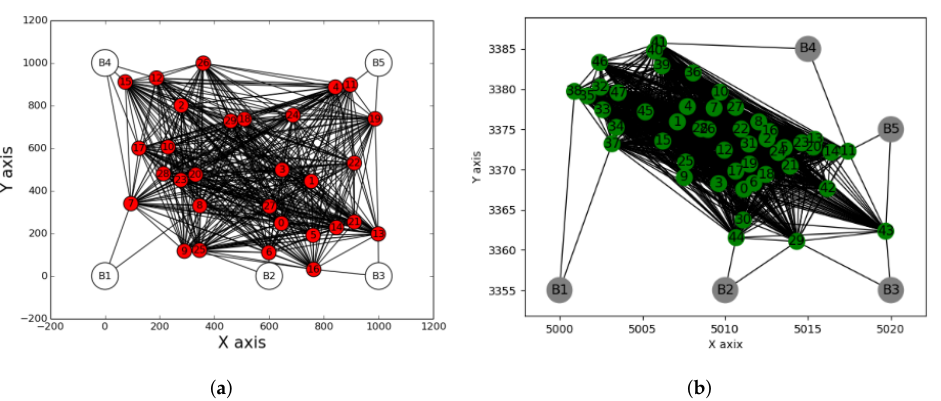
Figure 3. The considered networks. ( a ) Artificial network; ( b ) Real Cape Town